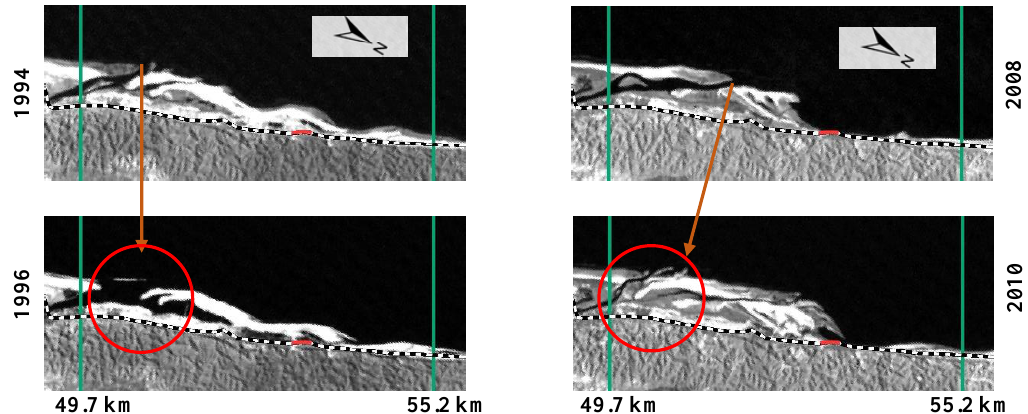
Figure 12. Examples of breaching. Reju River mouth location shifts as a result of breaching during 1994–1996 ( left ) and 2008–2010 ( right ). Red circles indicate breachings, and the shift of the river mouth to the southern delta.